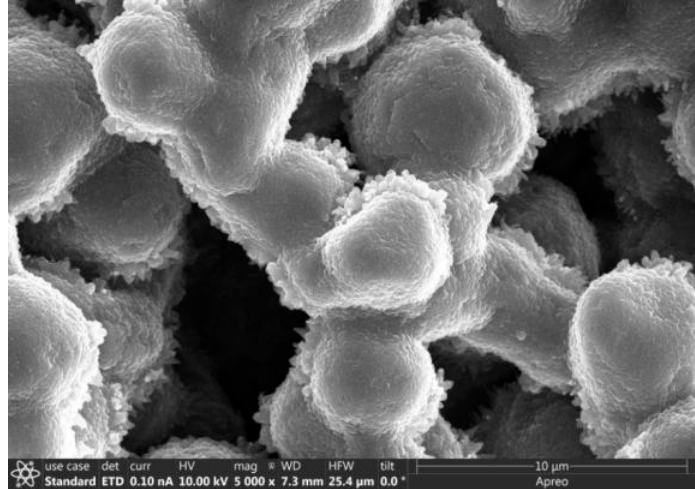
Figure 8. Graphitic structure obtained in hydrogen